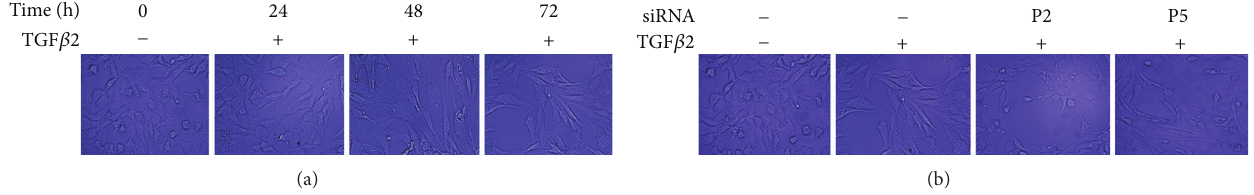
Figure 7: Morphological changes of HLEB3 cells. Serum starved HLEB3 cells were transfected with human Snail siRNA (P2) and negative control siRNA (P5) before the cells were stimulated with TGF 𝛽 2. The morphology of the cells was observed under inverted microscope. (a) TGF 𝛽 2-induced cells became spindly shaped. (b) Snail targeting siRNA prevented the cells from the TGF 𝛽 2-induced morphological change (200x).